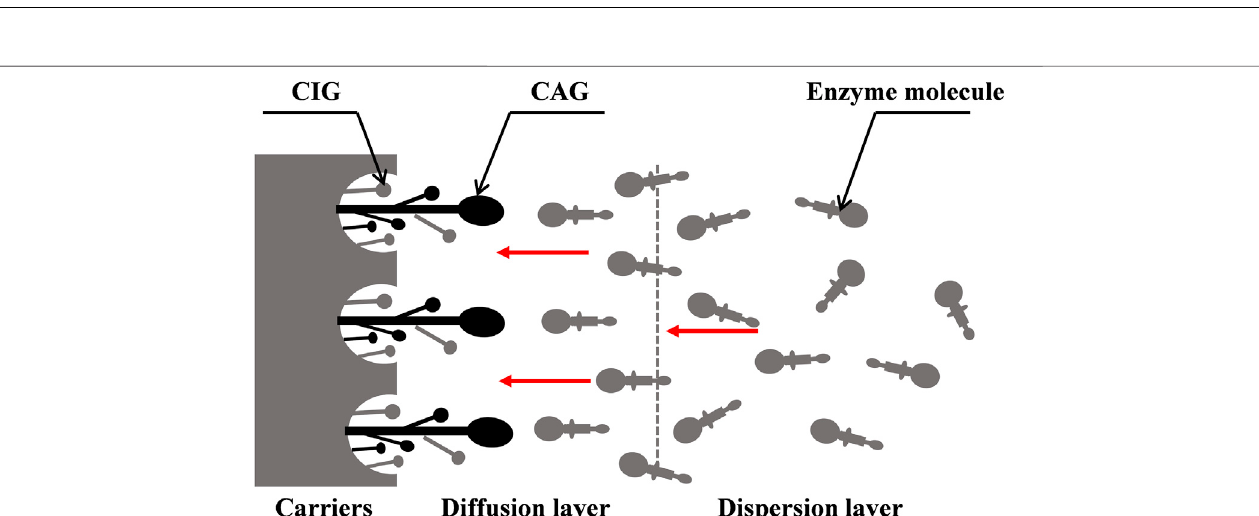
FIGURE 2 | Binding schematic diagram of enzyme and carrier caused by the chemistry properties during the immobilization process. CIGs means the carrier- bound inert groups and CAGs means the carrier-bound active groups; The larger end of enzyme molecule stands for the catalytic domain and the other end stands for the adsorption